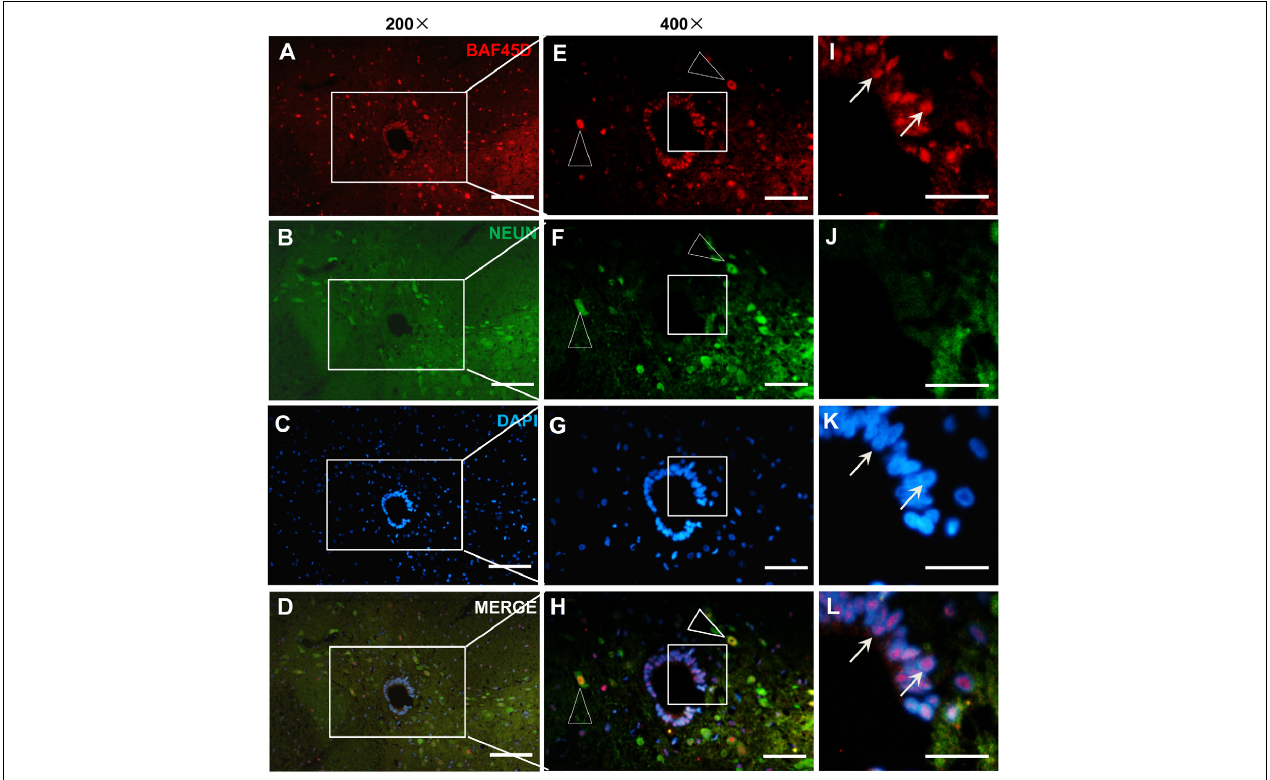
FIGURE 2 | Expression of BAF45D and NEUN in the SCECs and neurons of intact spinal cords from adult rats. (A–D) Immunofluorescence assays were performed on histological sections prepared from the intact spinal cords of adult rats using anti-BAF45D and anti-NEUN antibodies. (E–H) Show 400 × magnification of the insets shown in (A–D) , respectively. The triangles indicate neurons positive for both BAF45D and NEUN. (I–L) represent 1200 × magnification of the insets shown in (E–H) , respectively. The arrows indicate SCECs positive for BAF45D. Scale bars: 100 µ m (A–D) , 50 µ m (E–H) , and 25 µ m (I–L) .